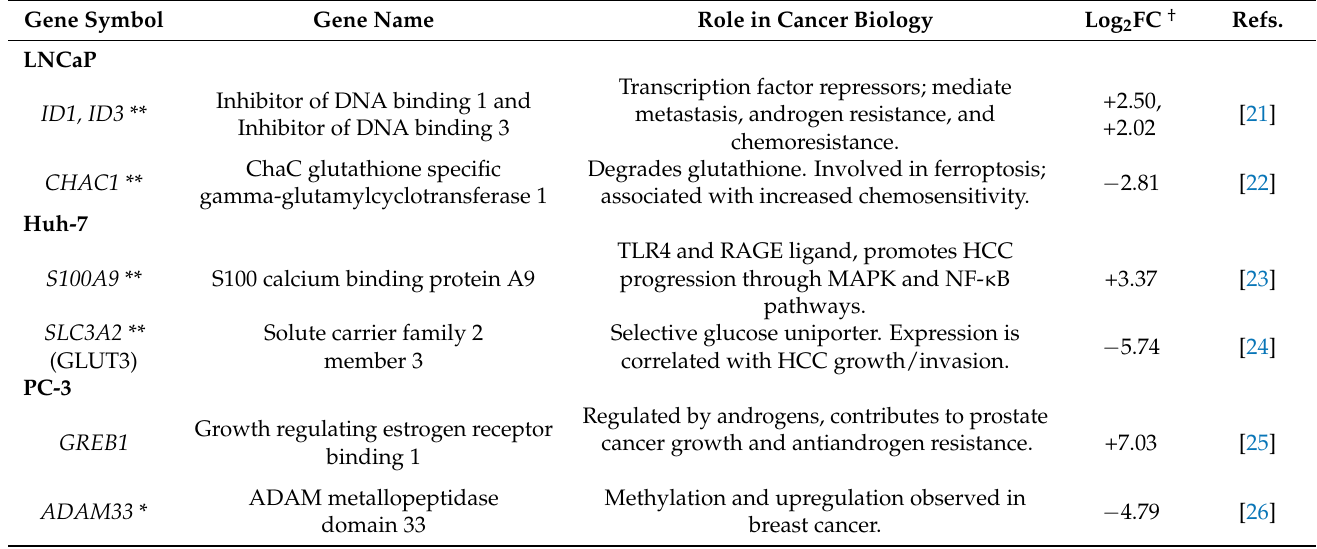
Table 1. Selected DEGs at 18% O 2 vs 5% O 2 with important roles in cancer biology.